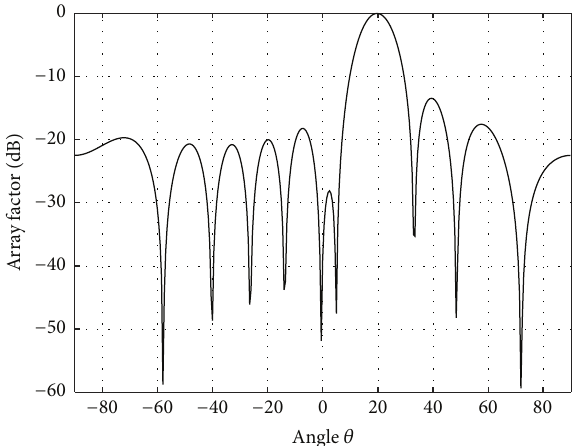
Figure 8: Normalized radiation pattern of the linear antenna array: the angle of arrival of the desired signal is 20 ∘ and the angle of arrival of the interfering signal is 5 ∘ ; SNR = 7